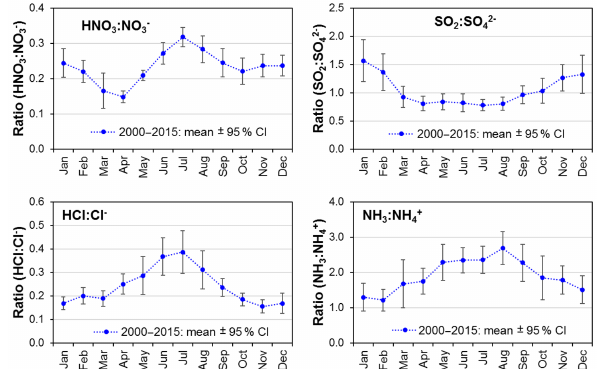
Figure 9. Average annual cycles in the ratios of gas:aerosol com- ponent concentrations. HNO 3 , SO 2 , HCl and aerosol NO − Cl − data (annual mean, µgm − 3 ) are from the UK Acid Gases and Aerosol Monitoring Network (AGANet). NH 3 and NH + nual mean, µgm − 3 ) that are measured at the same time for the UK National Ammonia Monitoring Network (NAMN, Tang et al., 2018) are also shown for comparison. Each data point in the graphs rep- resents the mean ± 95% confidence interval (CI) of monthly mea- surements of 12 sites operational in the network over the period 2000 to